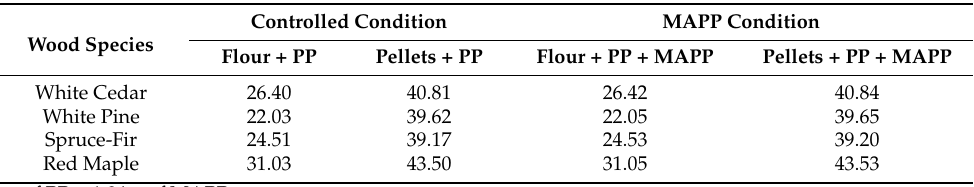
Figure 2. Fluorescent images of WPCs with MAPP ( a ) Cedar flour, ( b ) Cedar pellets, ( c ) Pine flour, ( d ) Pine pellets, ( e ) Spruce-fir flour, ( f ) Spruce-fir pellets, ( g ) Maple flour and ( h ) Maple pellets. The feed rate of the raw materials under different formulations is shown in Table 2. Table 2. Feed rate (g/min) from the feeder of twin-screw